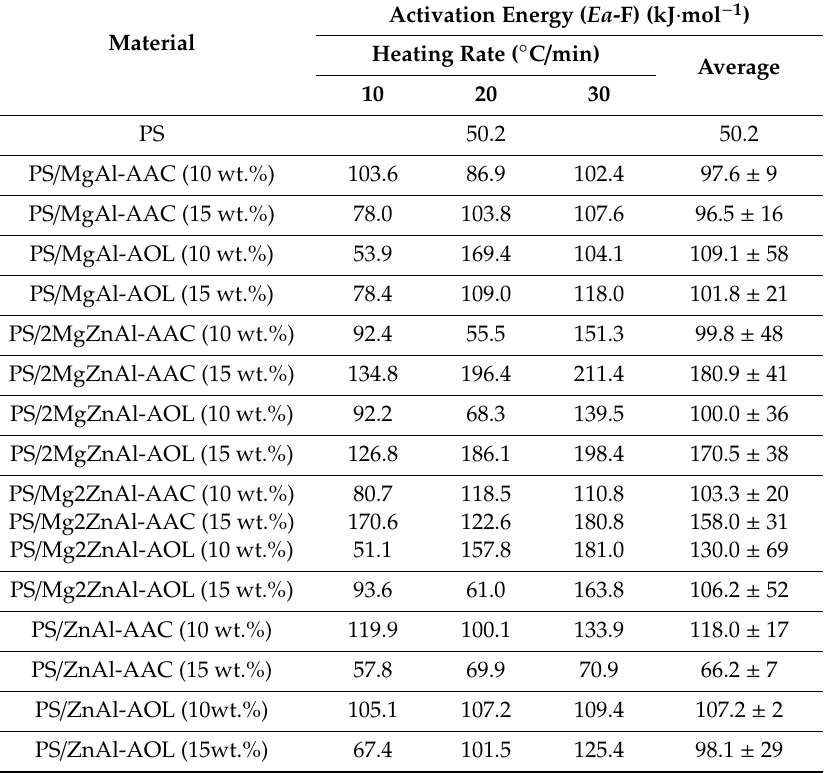
Table 6. Activation energies obtained using the Friedman